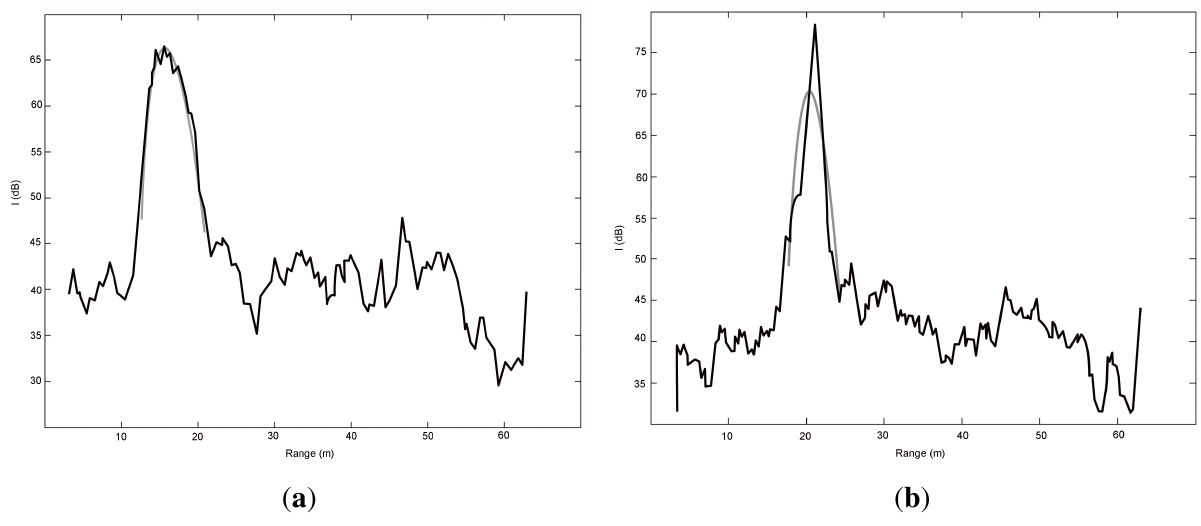
Figure 6. Example of good fit (SE = 94.0 dB 2 ) ( a ), and poor fit (SE = 913.1 dB 2 ) ( b ). Black: radar observation. Grey: Radar-Centric Ground Detection (RCGD) ground echo